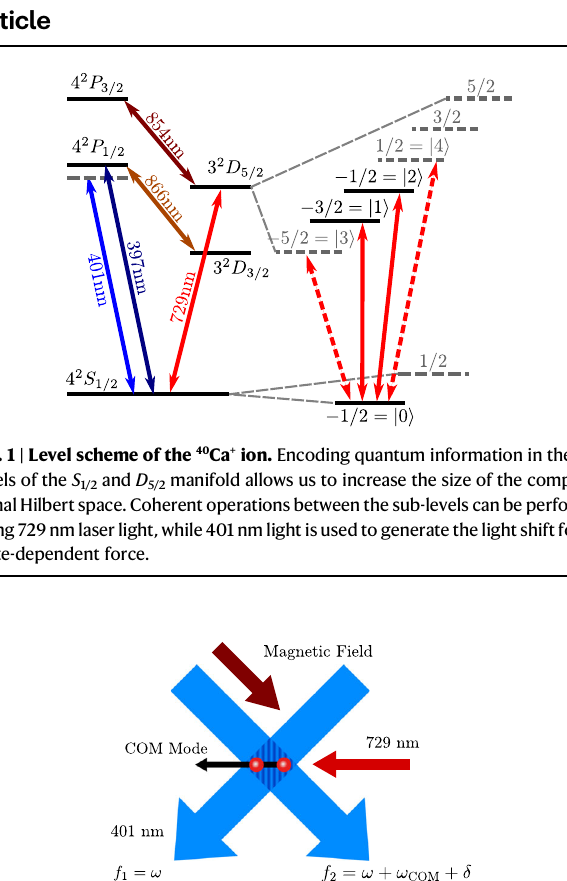
Fig.2|Experimentalsetup. Twobeamswith λ =401nmandfrequencies f 1 , f 2 with a relative detuning of ω COM + δ are intersected at a 90 ∘ angle to drive the state- dependentforce.A729nmlaseralongtheaxialtrapdirectionisusedtoimplement local